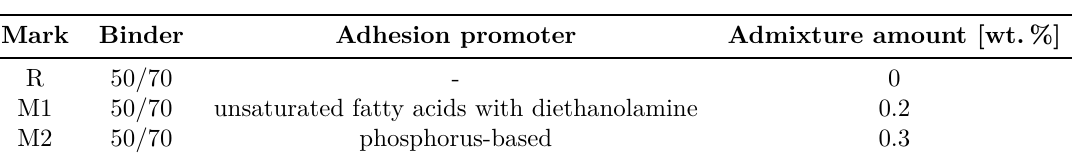
Table 1. Summarization of three variants of bituminous binder 50/70